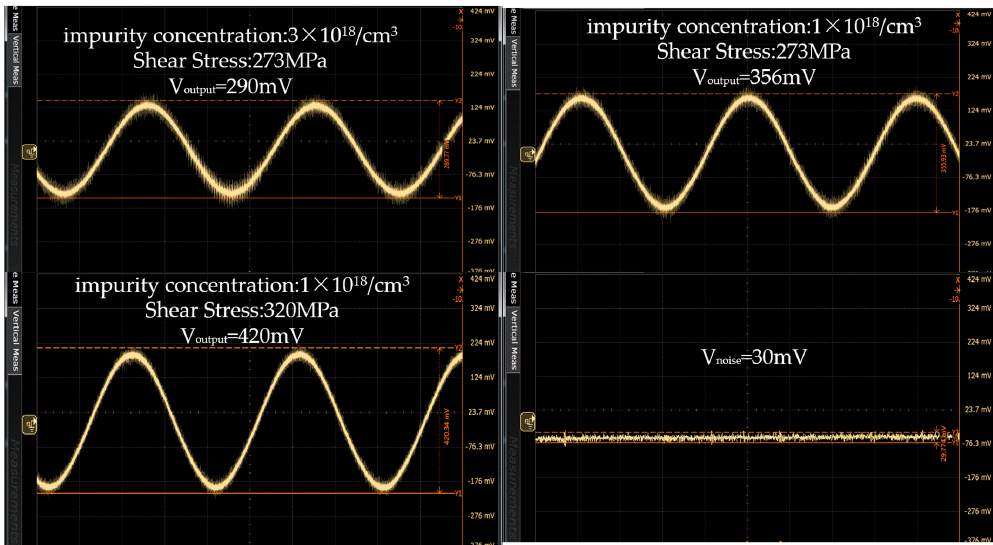
Figure 10. Comparison of output voltage of different impurity concentration and shear stress.